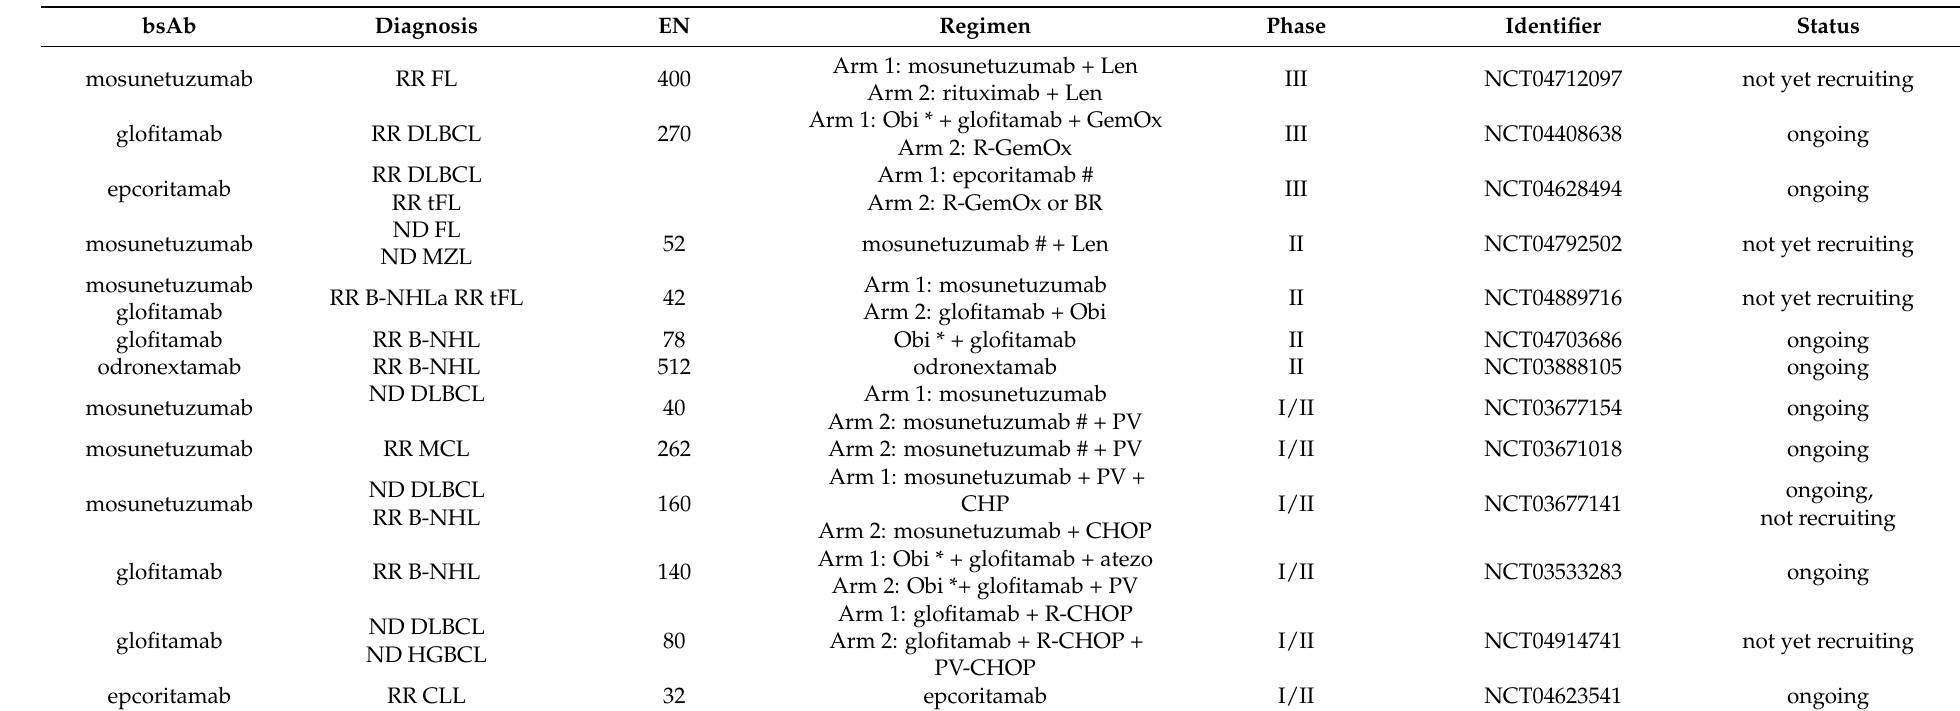
Table 5. Bispecific antibodies-phase I-III ongoing clinical trials with no available results; bsAb, bispecific antibody; EN, estimated enrollment; RR, relapse and/or refractory; ND, newly diagnosed; B-NHL, B-cell non-Hodgkin lymphoma; DLBCL, Diffuse large B-cell lymphoma; HGBCL, high-grade B-cell lymphoma; MCL, mantle cell lymphoma; MZL, marginal zone lymphoma; CLL, chronic lymphocytic leukemia; FL, follicular lymphoma; tFL, transformed follicular lymphoma; atezo, atezolizumab; PV, polatuzumab vedotin; CHOP, cyclophosphamide, doxorubicin, vincristine, prednisone; CHP, cyclophosphamide, doxorubicin, prednisone; R, rituximab; mosunetuzumab, TCE anti-CD20xCD3, glofitamab, TCE anti-CD20xCD3;